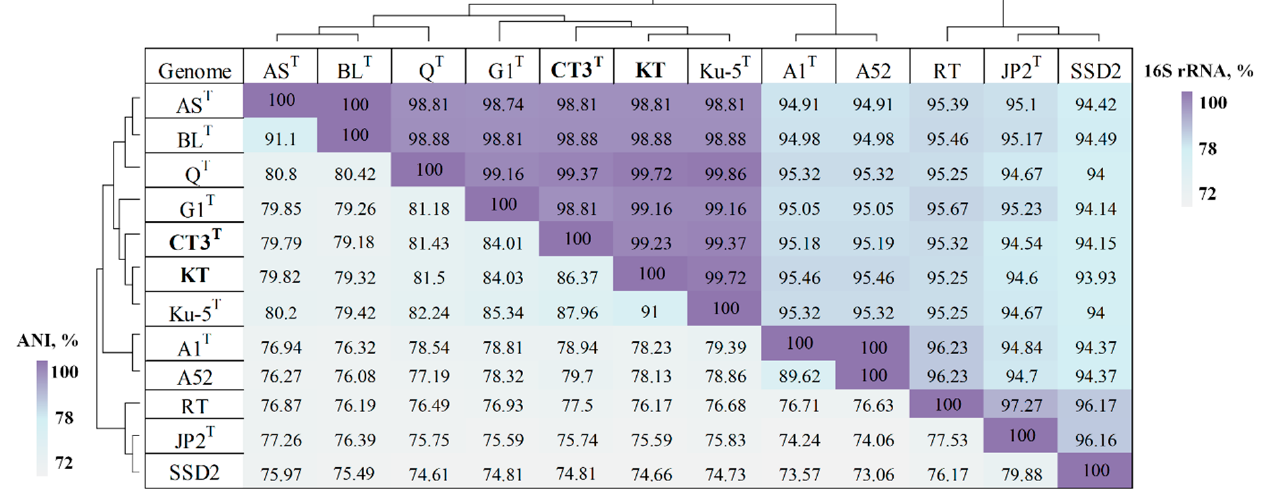
Figure 2. 16S rRNA and ANI pairwise values for Thiothrix genomes. T. lacustris BL T